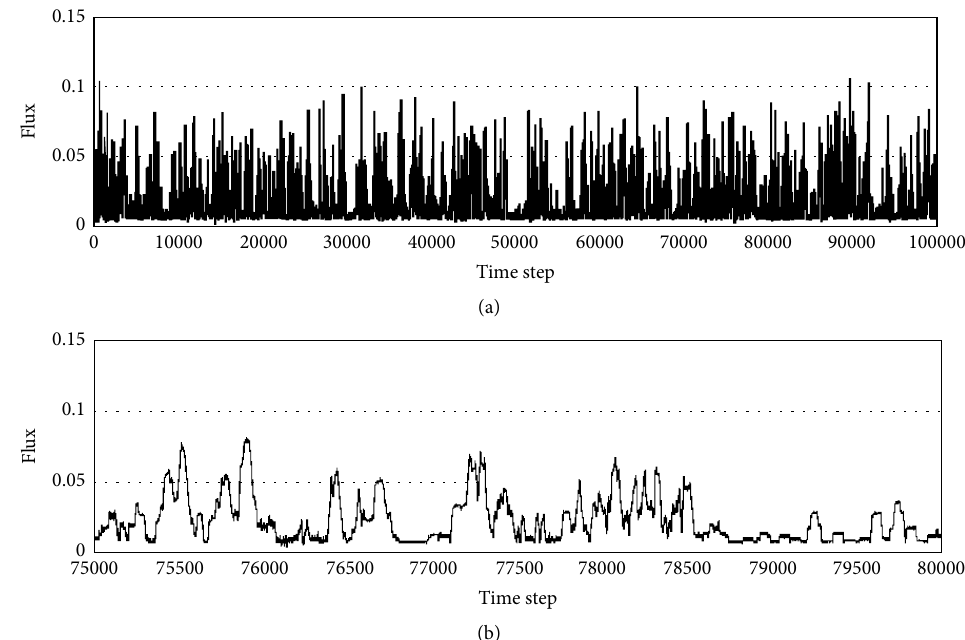
Figure 3: Changes in the flux over time for the multi-state NS model with a vehicle density of 0.40, showing. (a) All data for 100,000 time steps and (b) a subset of the data. Here, 𝑝 = 0.01 , v max = 5 , threshold_slow = 5, and threshold_acceleration =